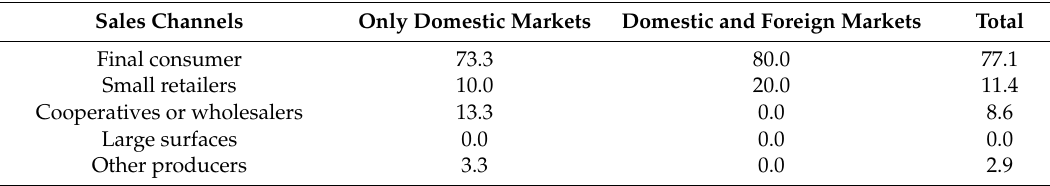
Table 4. Relative frequency (%) of sales channels by type of